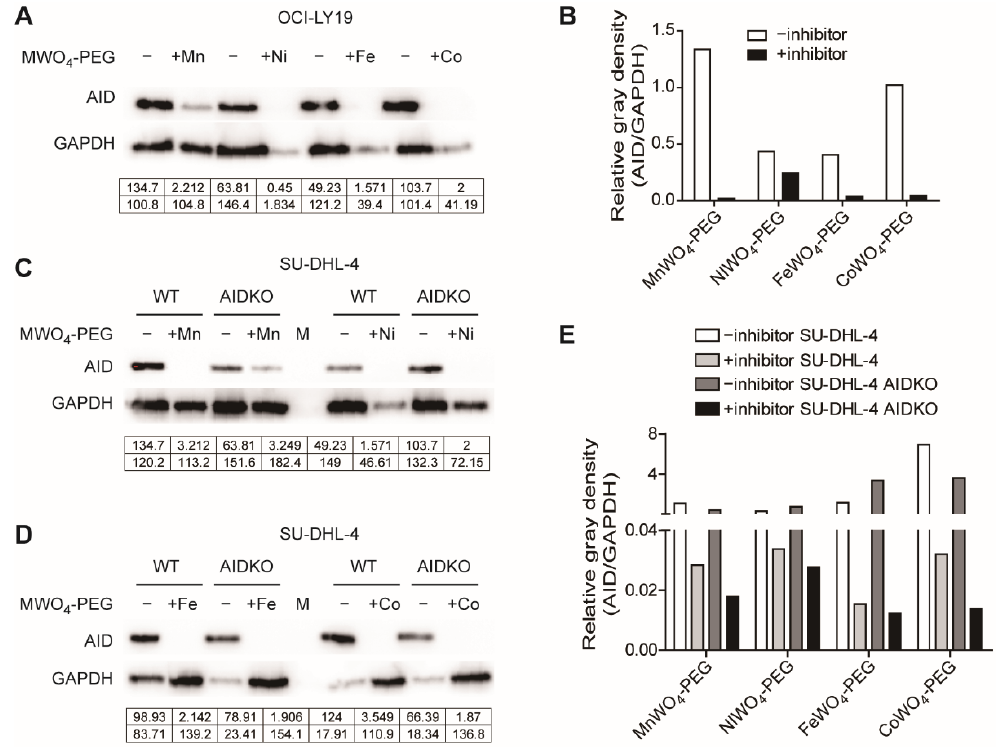
Figure 6. Inhibition of MWO 4 -PEG NPs to AID in DLBCL. ( A ) The AID and GAPDH protein level of OCI-LY19 DLBCL cells with the treatment of four NPs with the concentration of 200 μ g/mL in the presence of US irradiation. The gray density was indicated under these bands correspondingly. ( B ) The bars showed the relative gray density of AID to internal protein GAPDH in inhibitor-treated OCI-LY19 cells. ( C ) The AID and GAPDH protein level of SU-DHL-4 and SU-DHL-4 AIDKO DLBCL cells with the treatment of MnWO4-PEG NPs and NiWO 4 -PEG NPs with the concentration of 200 μ g/mL with US activation. The gray density was indicated under these bands correspondingly. ( D ) The AID and GAPDH protein levels of SU-DHL-4 and SU-DHL-4 AIDKO DLBCL cells with the treatment of FeWO 4 -PEG NPs and CoWO 4 -PEG NPs with the concentration of 200 μ g/mL. The gray density was indicated under these bands correspondingly. ( E ) The bars showed the relative gray density of AID to internal protein GAPDH in NPs treated with SU-DHL-4 and AIDKO SU-DHL-4 cells.